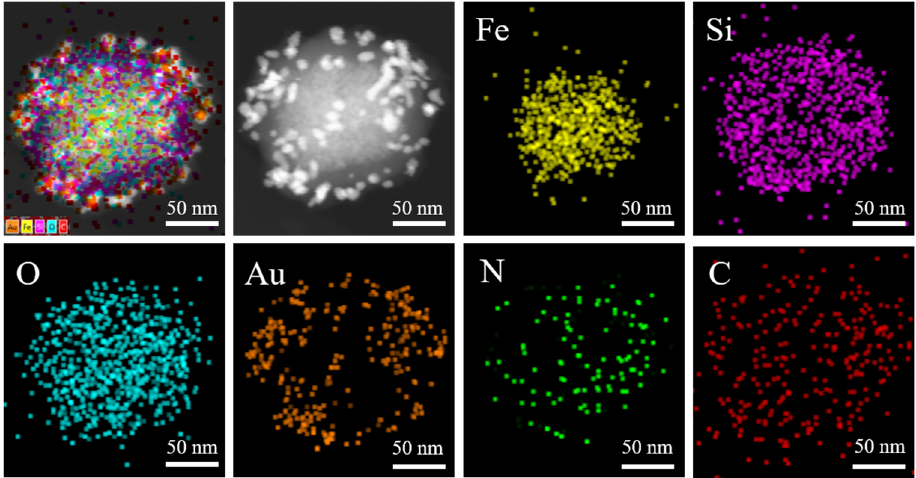
Figure 5. TEM images of high-angle circular dark-field scanning of monodispersed Fe 3 O 4 @SiO 2 @Au/PDA nanoparticles and elemental distribution of Fe, Si, O, Au, N, and C